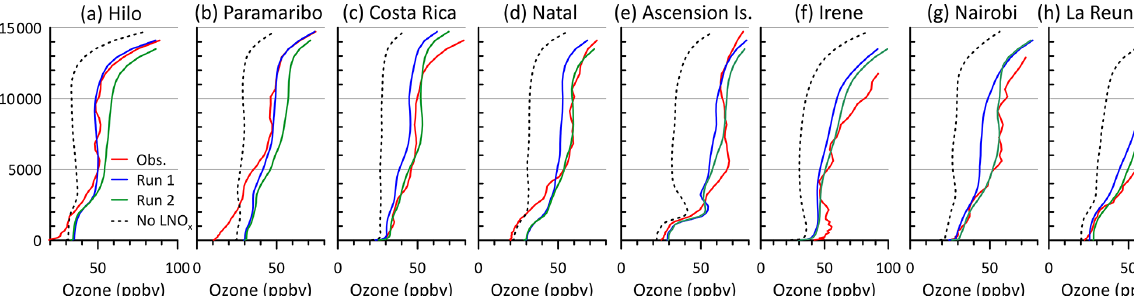
differences ( = [ ¯ M − ¯ O)/ ¯ O ] × 100 %) between the annual- averaged modelled and observed ozone for the PR92